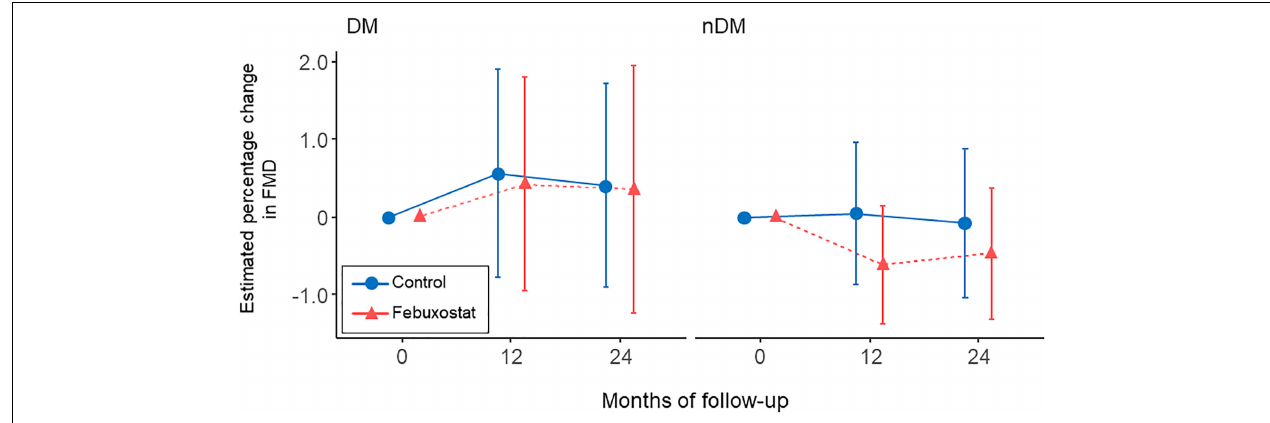
FIGURE 3 | Changes in estimated percentage change in flow-mediated vasodilation (FMD) in the febuxostat group and the control group according to the presence or absence of diabetic complications. The mixed-effects model included treatment, follow-up time, a treatment × follow-up time interaction term, age, sex, serum uric acid levels at each time point, and FMD at baseline. DM indicates diabetes mellitus; nDM, non-diabetes mellitus.